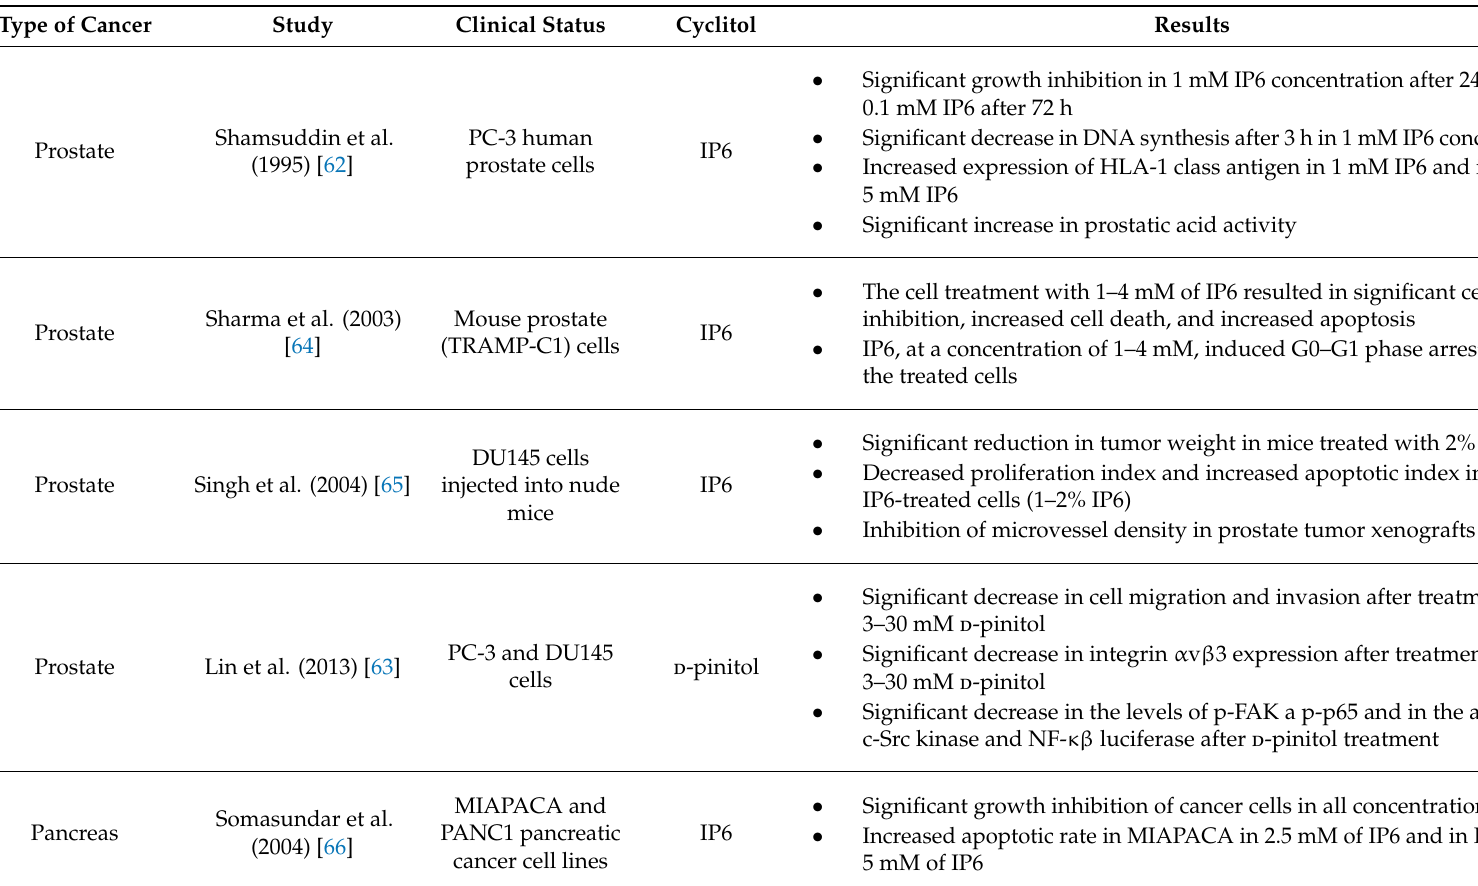
Table 4. Antineoplastic activity of cyclitols in other